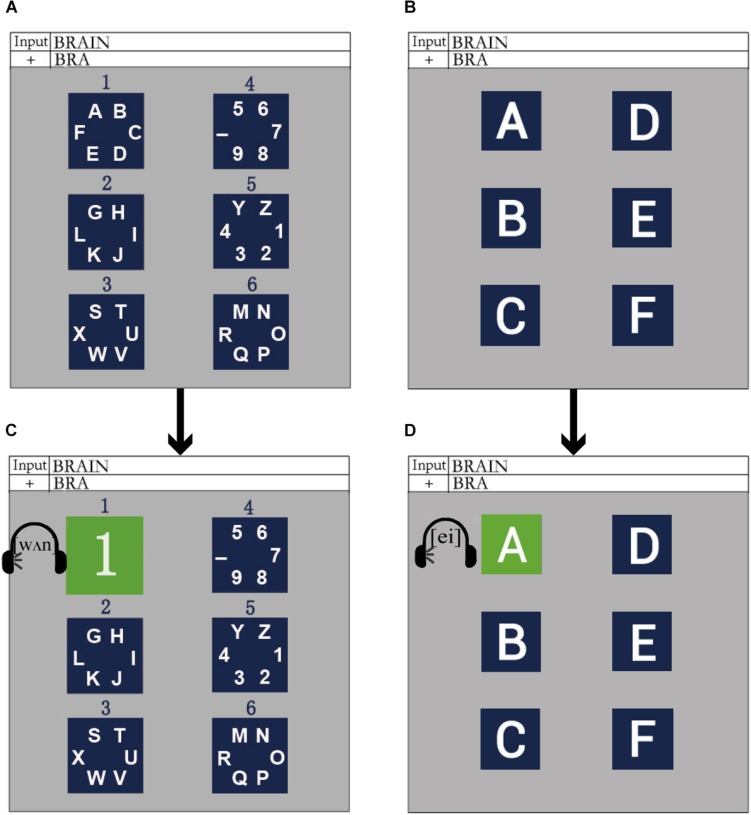
The stimuli and experimental paradigm in the audiovisual P300-speller. (A) The layout of level 1 in the AV spelling paradigm; (B) an example for the layout of level 2, which corresponded to group-area 1 in level 1 of the AV spelling paradigm; (C) an example for a group-area intensified in level 1 of the AV spelling paradigm; (D) an example for a sub-area highlighted in level 2 of the AV spelling paradigm.